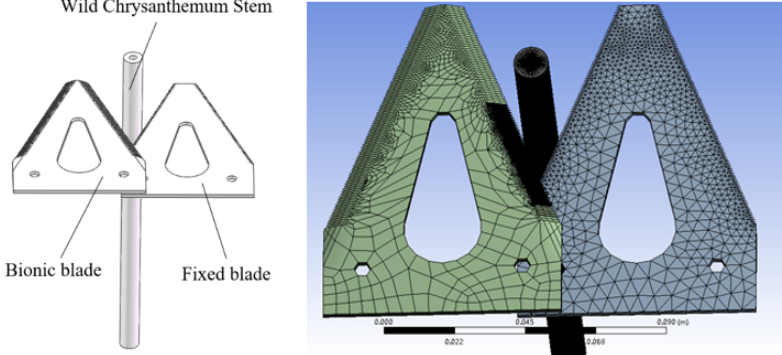
Figure 5. Stem cutting system of the wild chrysanthemum.